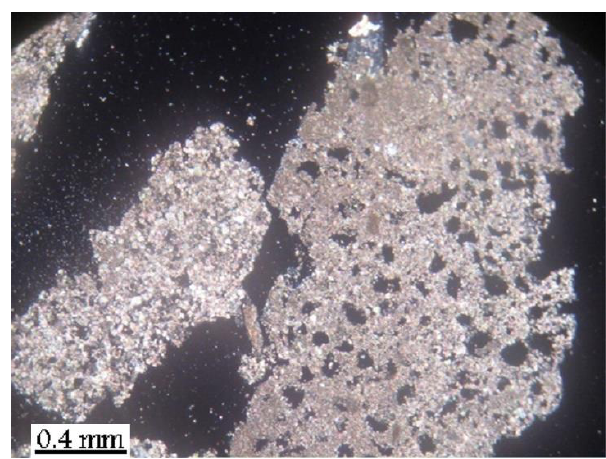
Figure 4. Dolomitization phenomenon in the studied samples